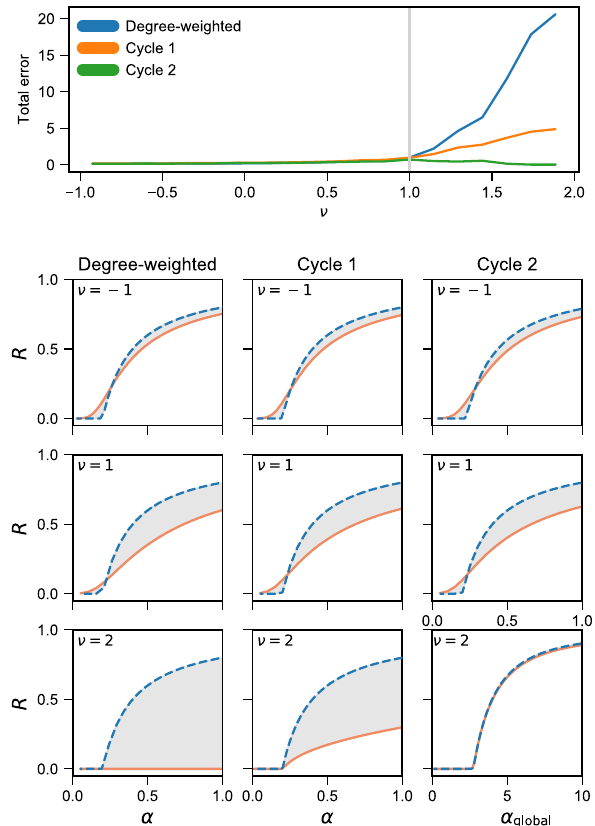
FIG. 7. (Top) Total error on the prediction of the global state activity at equilibrium for networks obtained from the generalized preferential attachment model [see Eq. (34)]. A gray line indicates the classical preferential attachment model at ν ¼ 1 where a critical transition in the reduced descriptions is found. The total error is averaged from 300 networks of N ¼ 200 generated uniformly on the domain ν ∈ ½ − 1 ; 2 (cid:2) . The activity on the network is the SIS model with γ ¼ 1 [see Eq. (2e)]. (Bottom) Instances of bifurcation diagrams for the three reduction schemes (columns) and for ν ¼ f − 1 ; 1 ; 2 g (rows). For the two-dimen- sional cycle reduction, the x axis is the average of the structural α α = 2 . The blue dashed lines are parameters: α 1 þ 2 Þ global ¼ ð predictions from reduced systems, and the orange lines are the measured activities on the original networks. The gray regions indicate the absolute errors [see Eq.